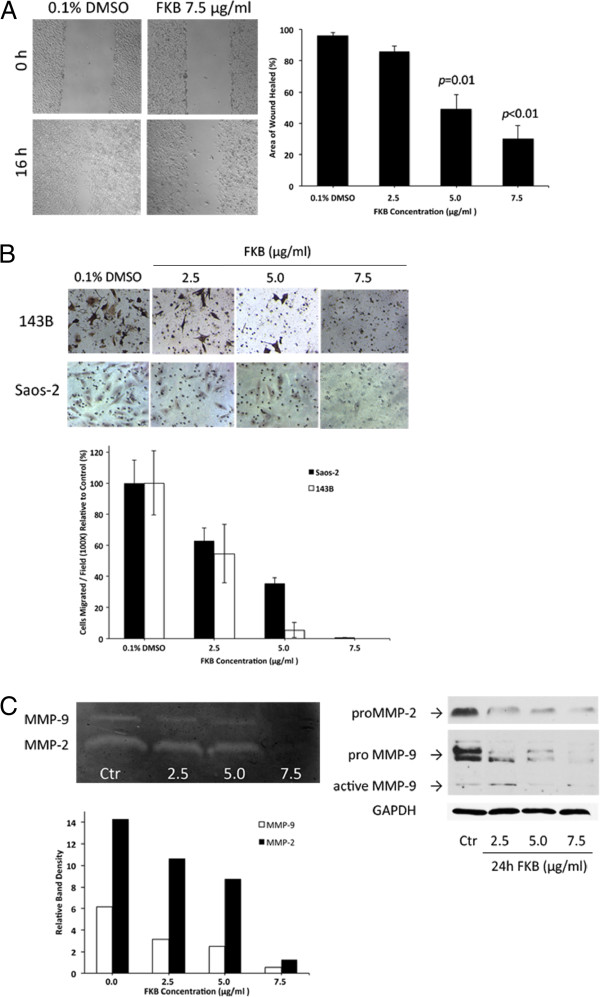
FKB suppressed cell motility and invasiveness. A, Representative photomicrographs of scratch wounds were taken at 0 and 16 h after wound were made on 143B treated with FKB 7.5 μg/ml or control. Quantitative measurement of wound healed by ImageJ software showed a reduced cellular motility in FKB-treated 143B cells compared with control group. Columns, mean relative area (%) of wound healed; bars, SD. Experiments were replicated thrice. B, Cell invasion ability was analyzed by the Transwell chamber 36 h after FKB treatment at indicated concentration. The number of migrated cells was significantly decreased by FKB in a dose-dependent manner. C, Zymography and western blotting analysis of MMP-2 and MMP-9 from cultured medium of 143B cells treated with FKB. Both MMP-2 and MMP-9 activities were significant inhibited by FKB. Also the same inhibition effect of FKB on MMPs was observed on protein expression levels.